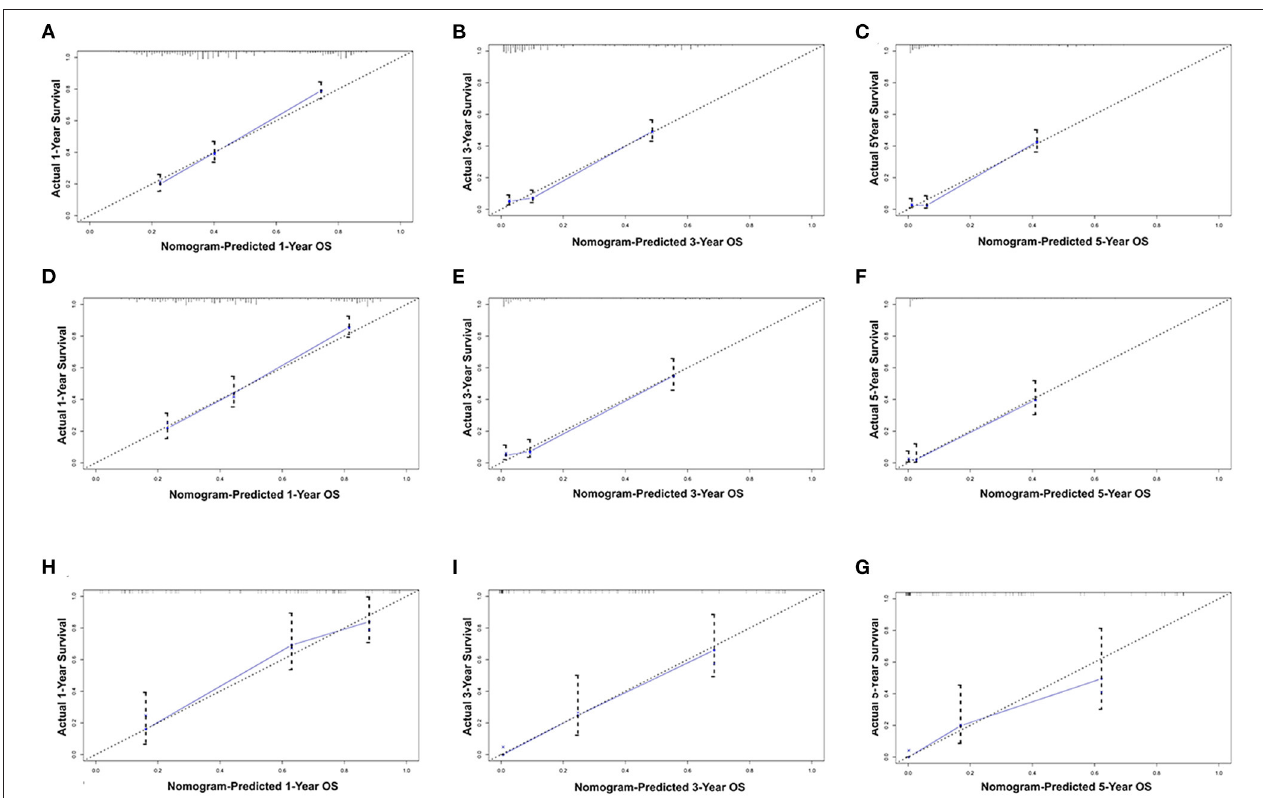
FIGURE 3 | Calibration plots of the nomogram for 1-, and 3-year OS prediction of the training set (A–C) and internal verification set (D–F) and external verification set (G–I) . X-axis represents the nomogram-predicted probability of survival; Y-axis represents the actual OS probability. A perfectly accurate nomogram prediction model would result in a plot that the observed and predicted probabilities for given groups fall along the line. Dots with bars represent nomogram-predicted probabilities along with 95% confidence interval. OS, overall